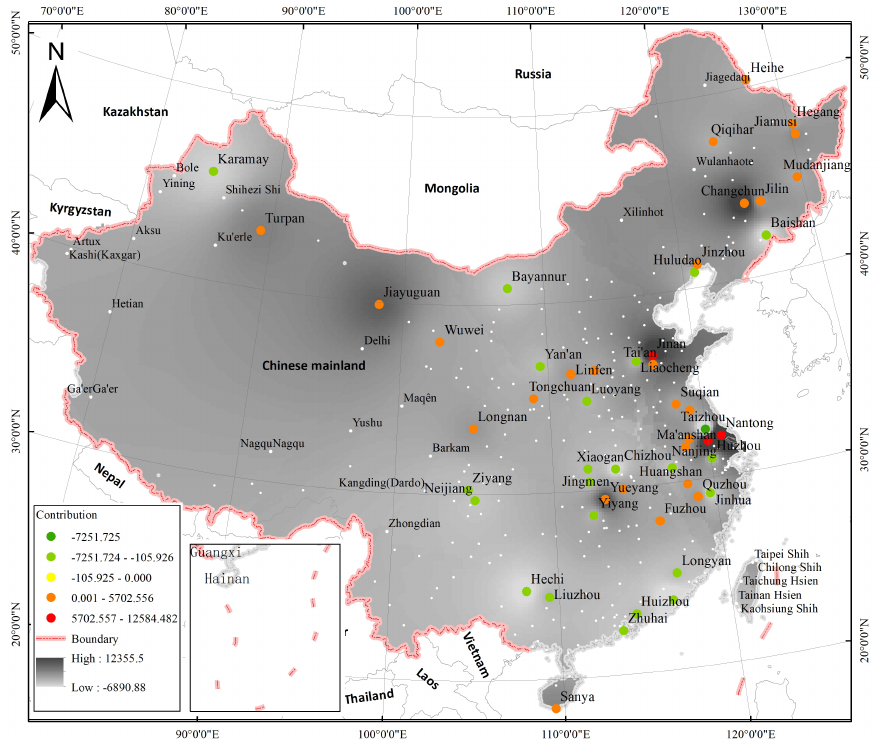
Figure A7. Contribution from the indicator GRPTIMD (proportion of tertiary industry gross regional product downtown) to land-use intensity revealed in the city-based